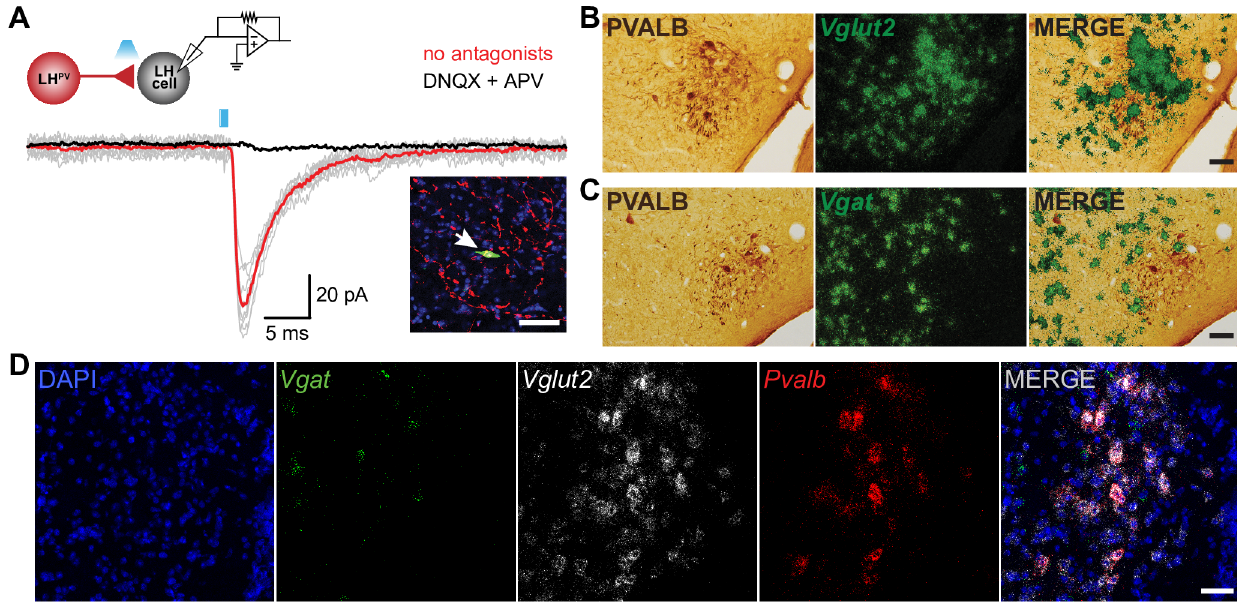
Fig 3. LH PV neurons are Vglut2 -positive and release glutamate. (A) Traces of excitatory postsynaptic currents (EPSCs; gray) evoked by photostimulation (1 ms light pulses) of LH PV -ChR2 + neurons before and after bath application of DNQX and APV (black trace; AMPA-R and NMDA-R antagonists). Red and black traces are the average of ten consecutive sweeps. LH neuron was held at − 70 mV. Note schematic of ChR2-assisted circuit mapping (inset; upper left) from LH PV -ChR2 + neuron (red) onto a postsynaptic lateral hypothalamic neuron (gray) as well as arrow indicating the recorded postsynaptic LH neuron (inset; bottom right) filled with biocytin (green) surrounded by ChR2:tdTomato-expressing LH PV dendrites/axons (red). Scale bar, 50 μ m. (B-C) Coronal sections showing that parvalbumin immunoreactive cells (brown; left panel) mainly colocalize with Vglut2 mRNA (95%; green grain aggregates; right panel) but not with Vgat mRNA (5%; green grain aggregates; right panel). Scale bars, 50 μ m. (D) Fluorescent in situ hybridization assay for Vgat (green), Vglut2 (white), and Pvalb (red) with DAPI (blue) counterstain. Pvalb mRNA was predominantly detected in neurons that express Vglut2 (95% Pvalb + /Vglut2 + ; 5% Pvalb + /Vgat + ) Scale bar, 50 μ m.